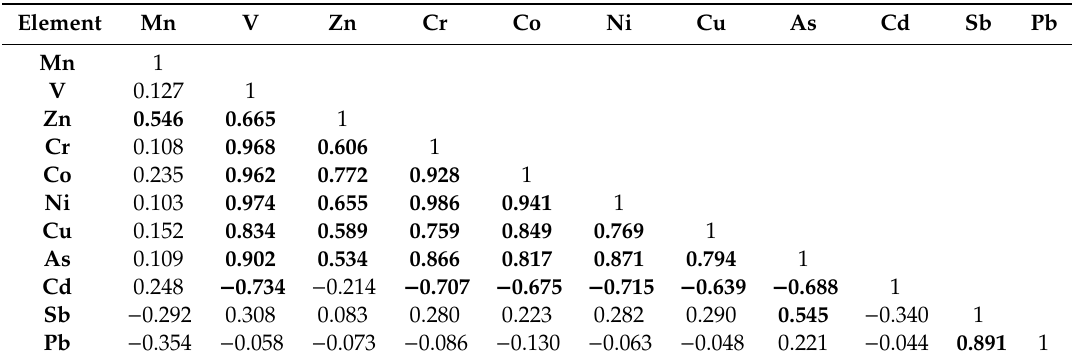
Table 5. Pearson correlation analysis for 11 PHTEs in 30 samples.